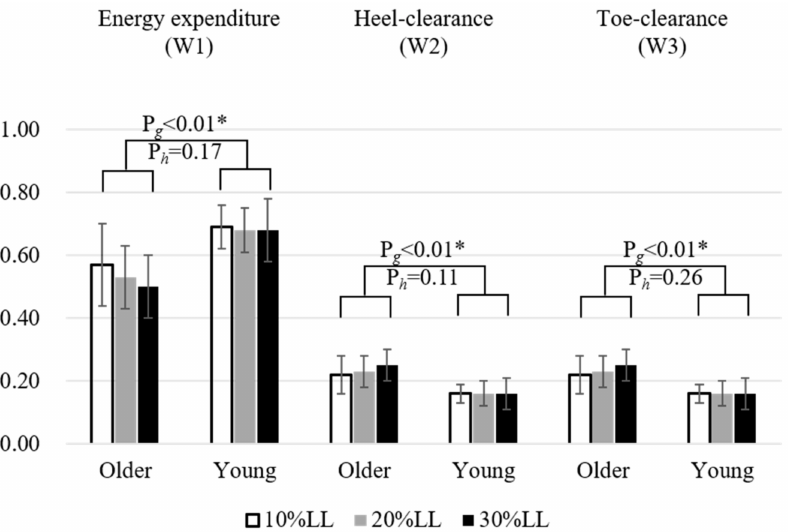
Figure 3. Means (standard deviations) of the best-compromise weighting sets (W1, W2, W3) for the older and young groups when crossing obstacles of three different heights: 10% (white), 20% (grey), and 30% (black) leg length (LL). p -values for the main effects are also given (Pg: group effects; Ph: height effects). Asterisks indicate statistically significant differences ( p <